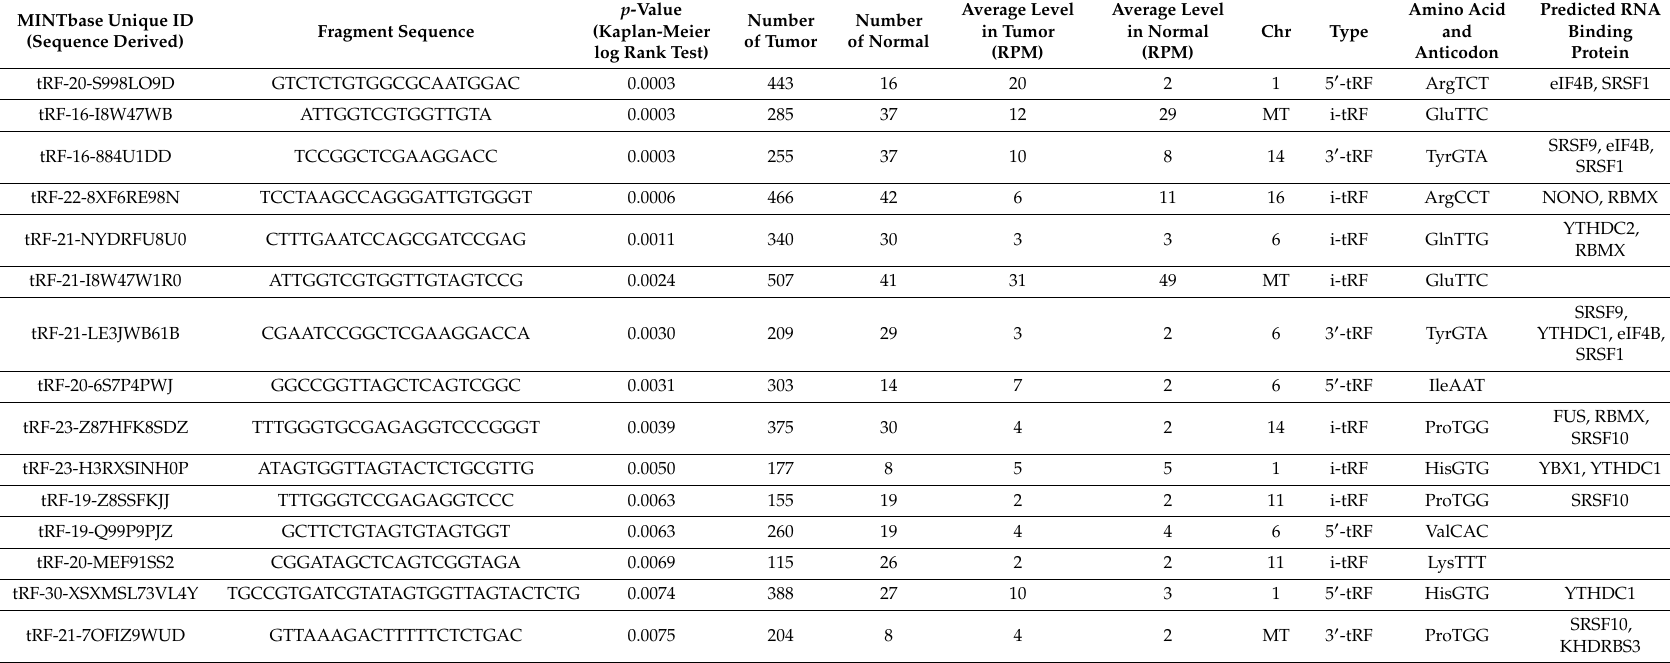
Table 1. Prognostic tRFs in